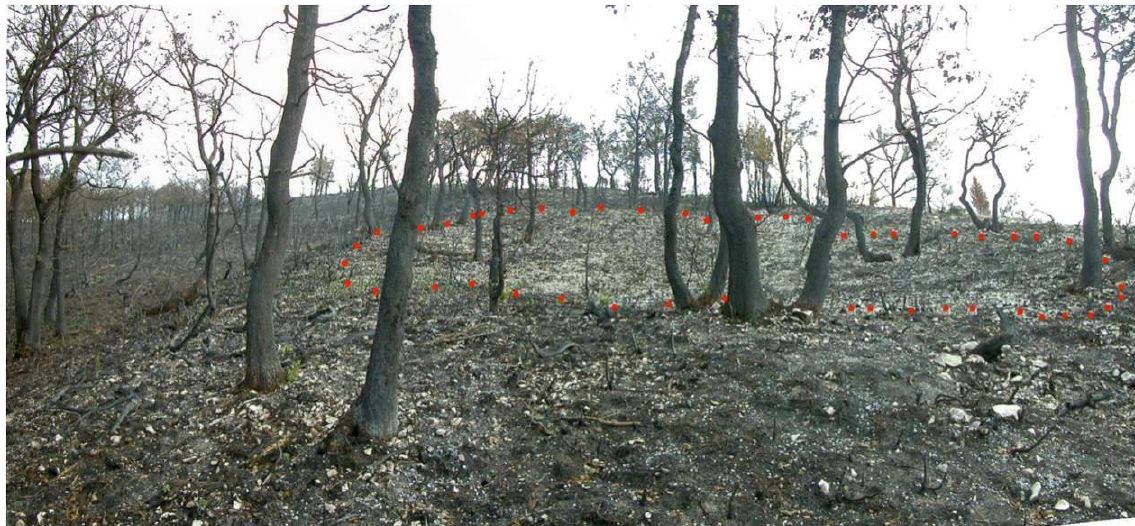
Figure 10. View of a crescent-shaped dump, showing the central depression before the excavation.